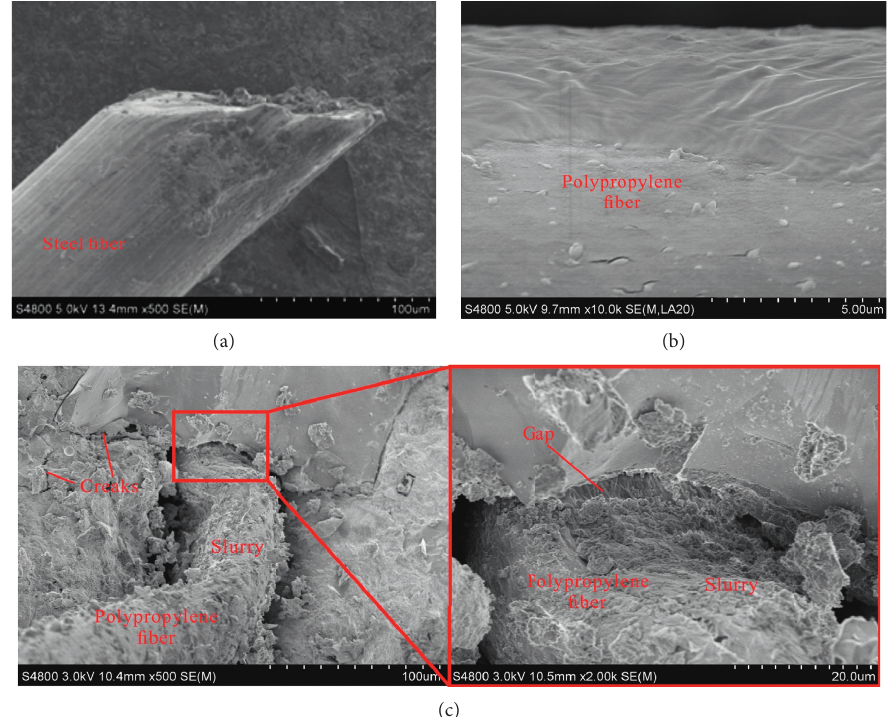
Figure 11: Microstructure of fiber-reinforced concrete.